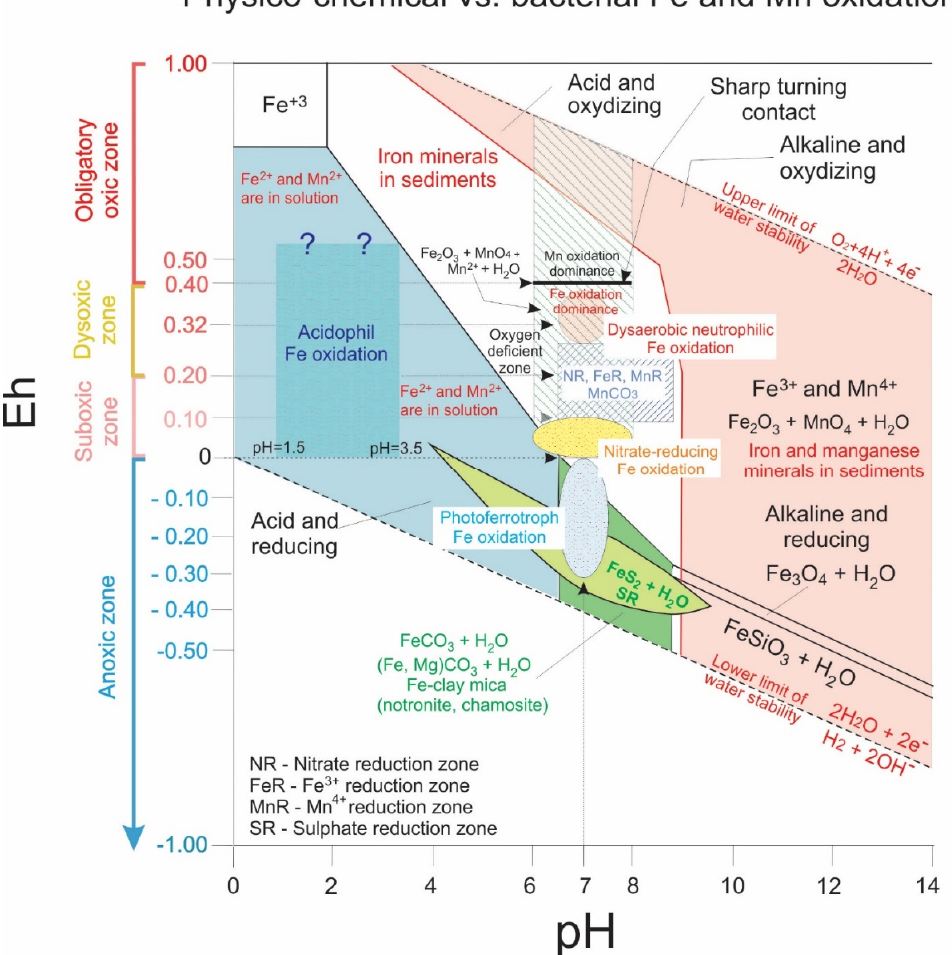
Figure 2. Physico-chemical vs. bacterial Fe and Mn oxidation (modified in accordance with [6,30,76] as cited from [6], with permission of Elsevier Publishing House). Eh is in volts. Concerning NR, FeR, MnR, and SR, see Table 2 and Figure 1 and note that “suboxic” zone is used for these diagenetic zones in the sense of an oxidant agent. Sharp-turning contact between Fe and Mn mineralization as transformation to obligatory oxic conditions is estimated at Eh = 0.4 V (DO > 2 mL/L).